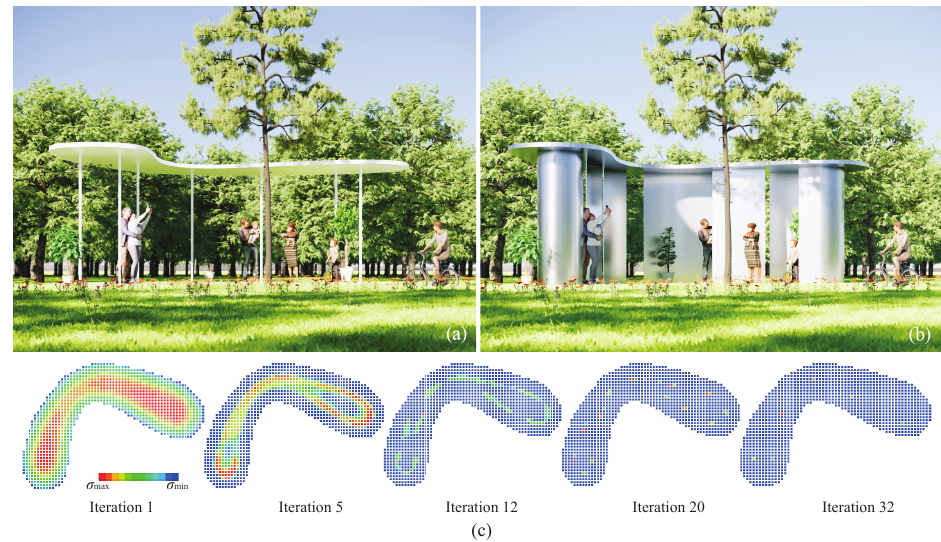
Figure 9. Design of pavilion with bean-shaped roof. ( a ) Roof–column structural system. ( b ) Installa- tion of curved panels. ( c ) Intermediate optimization